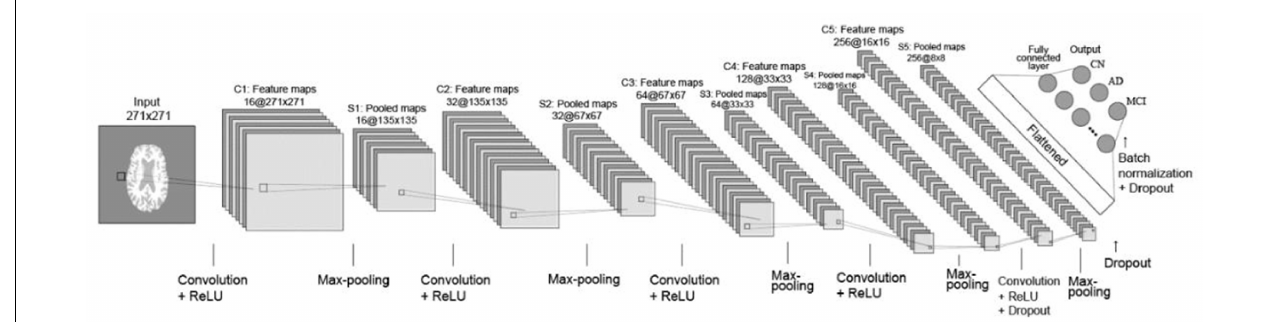
FIGURE 3 | Layout of CNN trained from scratch. Briefly, the architecture comprises the following: 5 convolutional layers followed by ReLU activation; 5 layers of max-pooling layers; 2 dropout layers; a flatten layer; a fully connected layer with 256 neurons followed by a dropout layer and a batch normalization layer; and ultimately an output layer with softmax activation, which outputs the probability of prediction for each